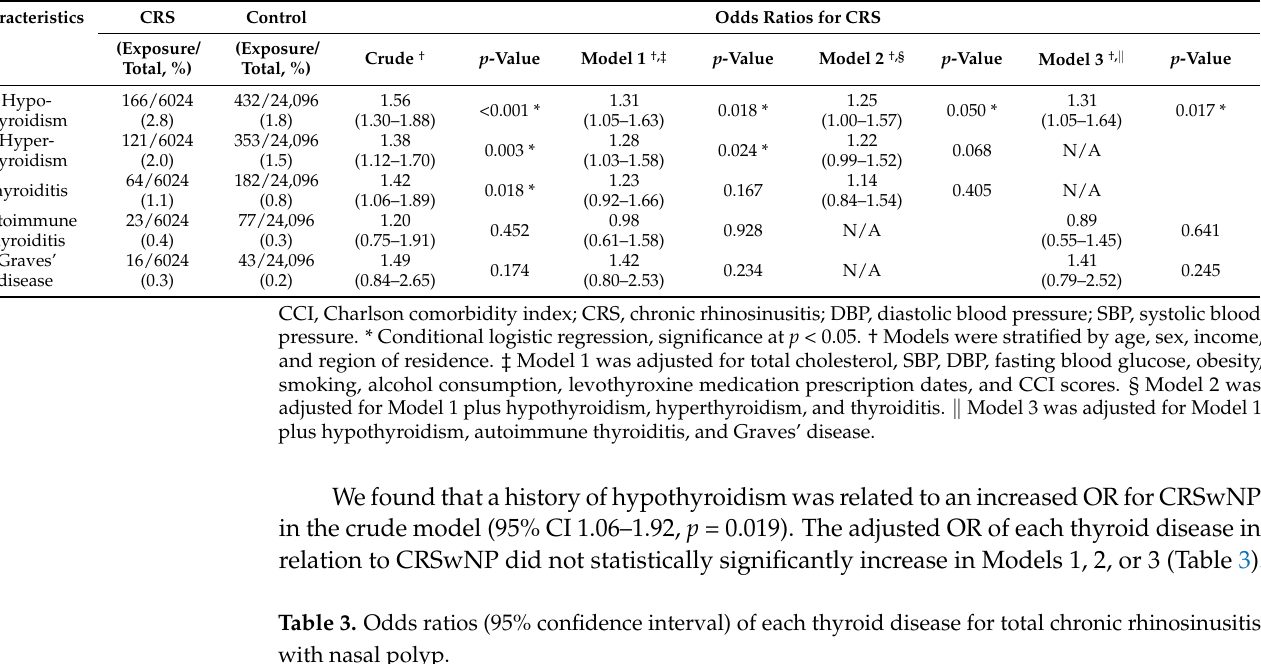
Table 2. Odds ratios (95% confidence interval) of each thyroid disease for total chronic rhinosinusitis.